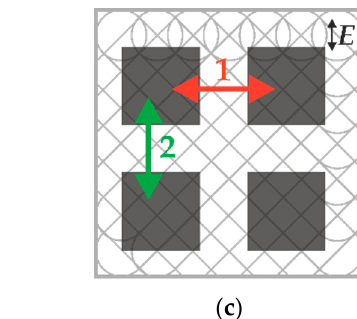
Table 1. Sample preparation parameters and formed LIPSS periods.